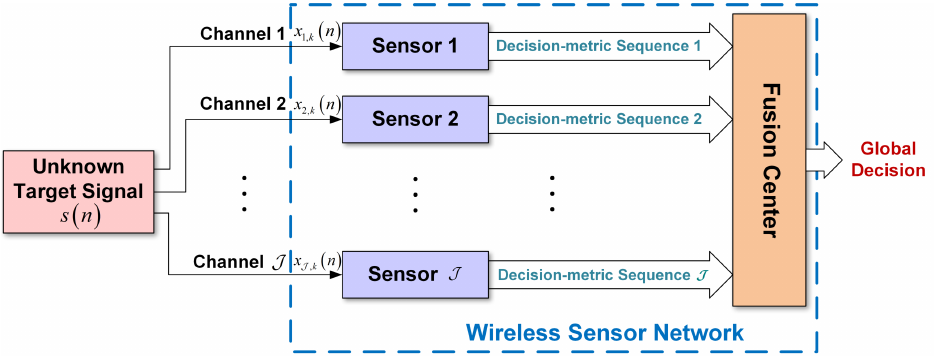
Figure 1. The system model of our proposed new CAMC scheme based on the vectorized soft decision fusion rule for wireless sensor